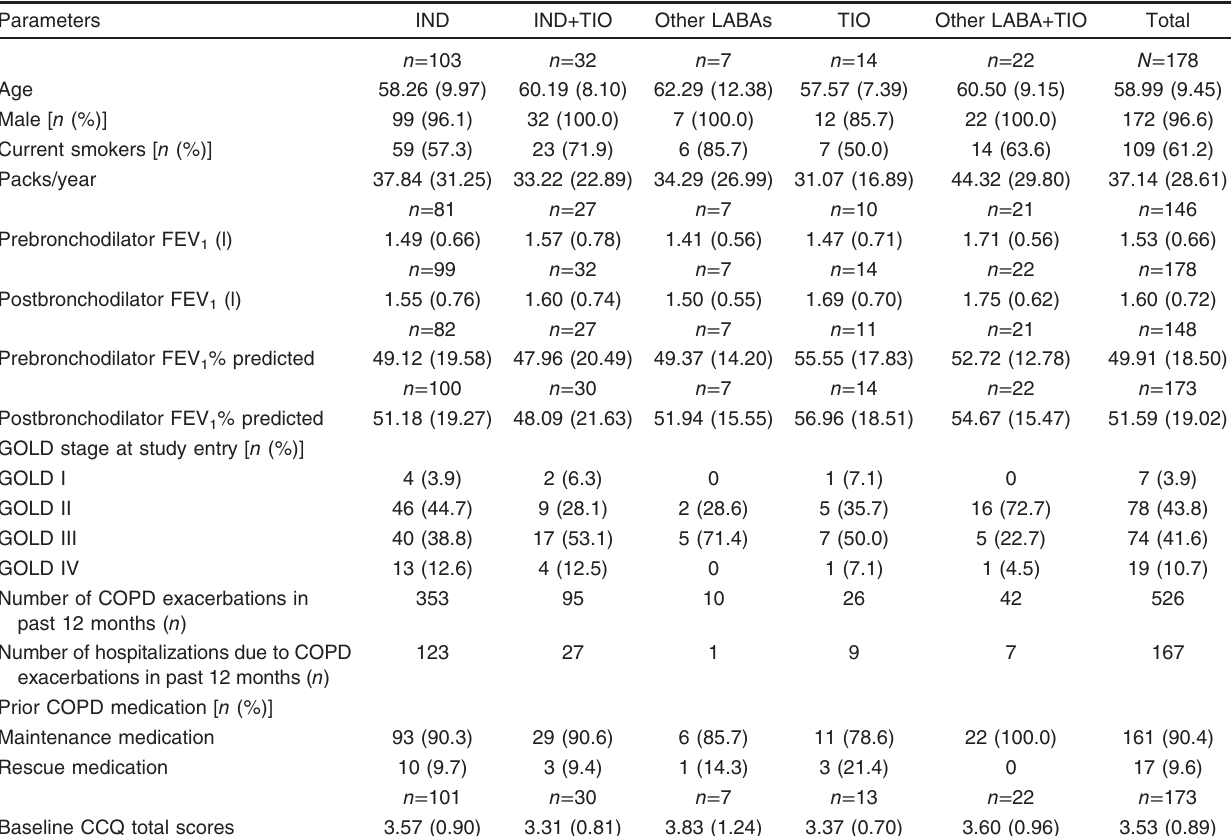
Table 1 Patients ’ demographics and baseline characteristics Parameters